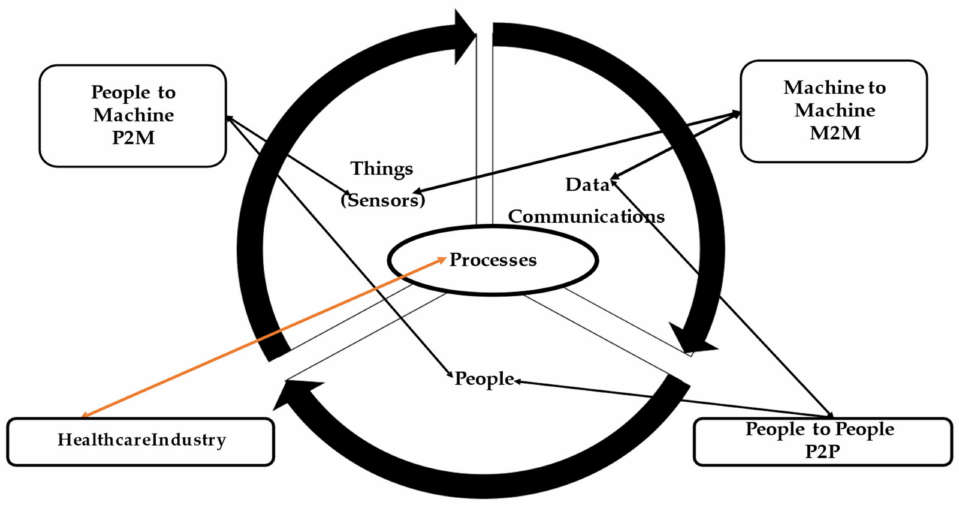
Figure 4. IoHE Pillars in